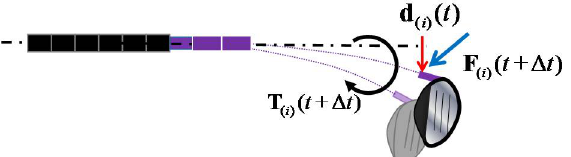
Figure 3. Deflection torque at the i -th element. We define the displacement of the i -th node at t as d ( i ) ( t ). We then define the generalized force acting on the i -th node at t + Δ t as F ( i ) ( t + Δ t ). The deflection